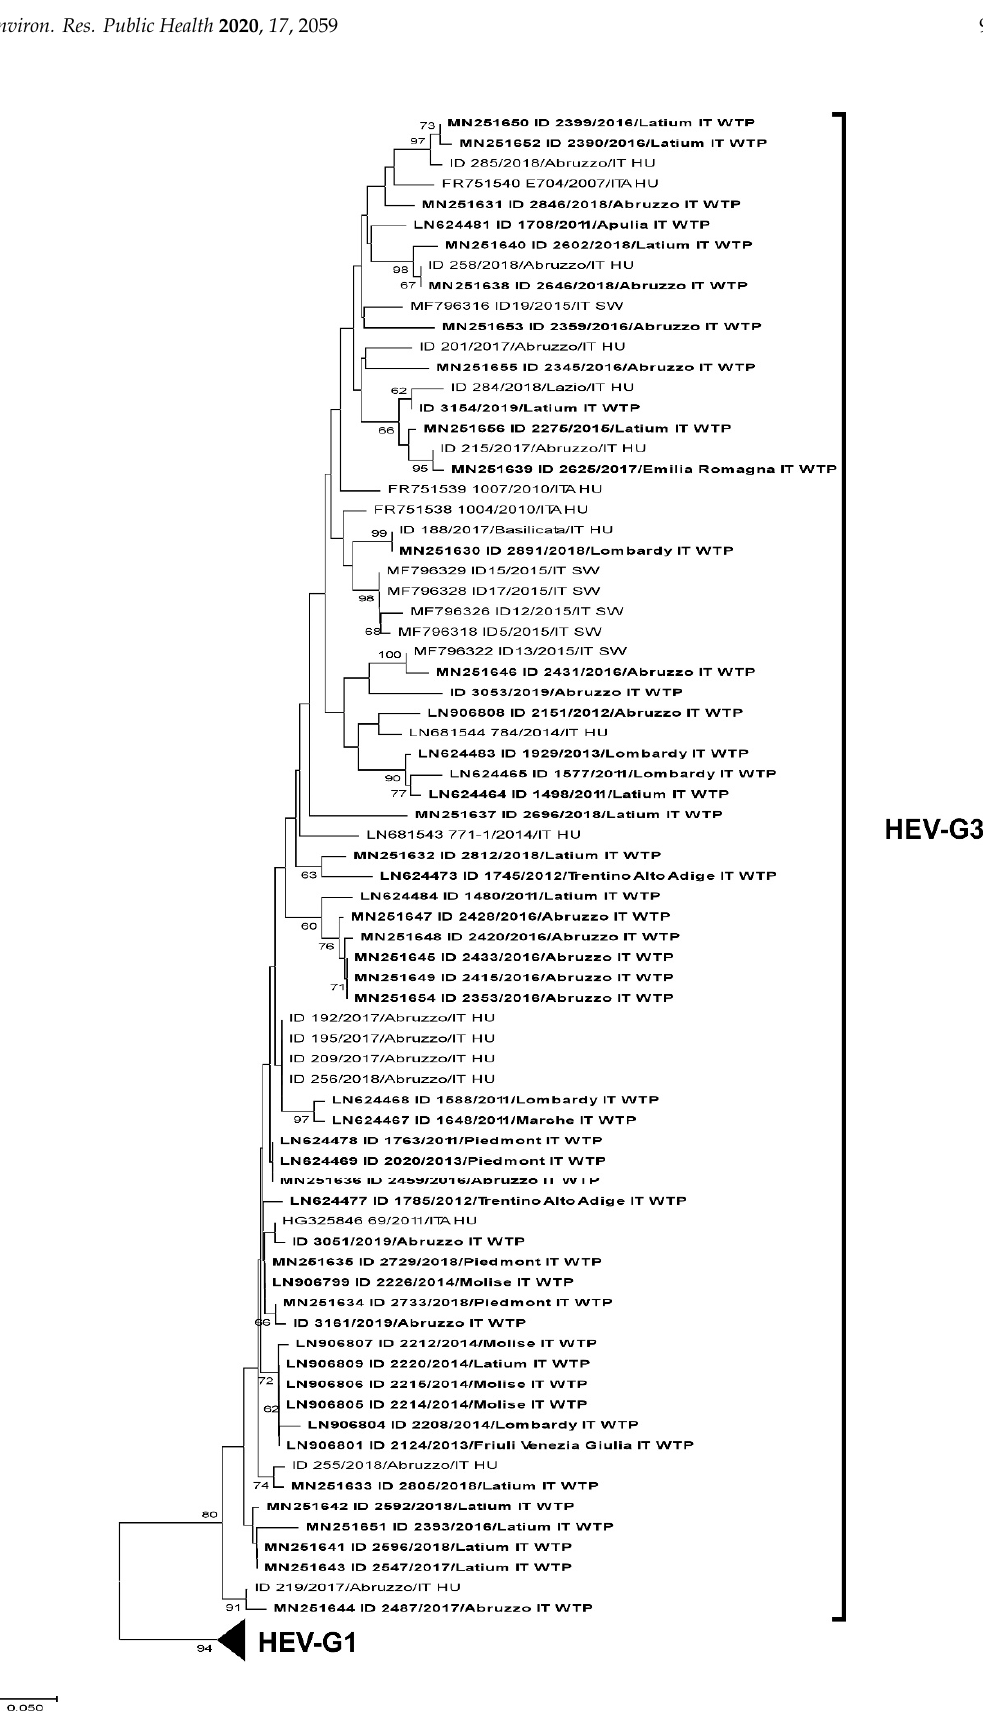
Figure 4. ( A ) Neighbor-joining phylogenetic tree of HEV-G3 sequences. Figure 4.